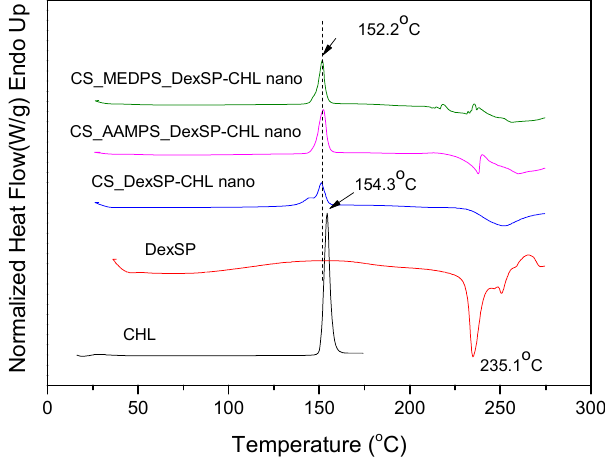
Figure 8. DSC thermograms of neat drugs and encapsulated in CS, ACS-AAMPS and CS-MEDSP nanoparticles.